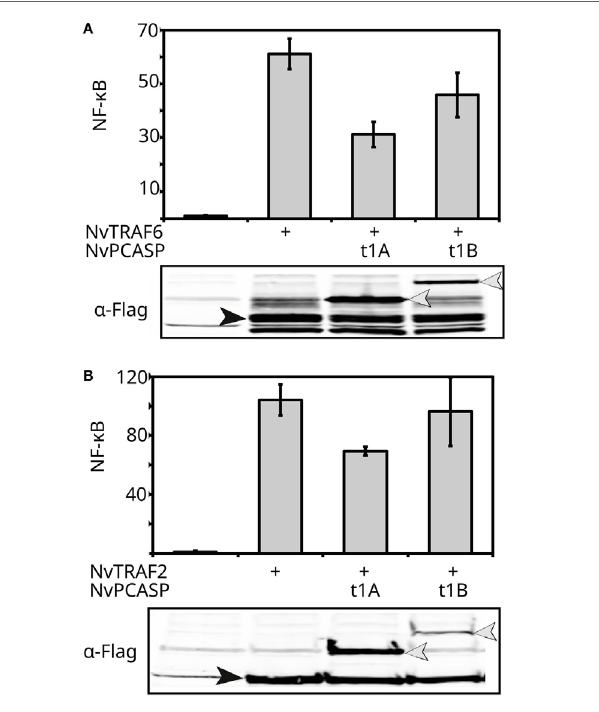
FigUre 4 | Functional conservation of cnidarian TRAF6 and TRAF2. (a,B) Nematostella vectensis (Nvn) TRAF6 (a) or TRAF2 (B) was expressed in human HEK293T cells together with an NF- κ B-dependent luciferase reporter gene and a constitutively expressed β -galactosidase reporter gene plasmids. The TRAF was transfected either alone or together with the indicated Nvn HLH-paracaspase fusion protein. Luciferase values were normalized against β -galactosidase and expressed as fold induction compared to samples not expressing the TRAF. Error bars represent 95% confidence intervals (Student’s t -distribution). The lower part of the panel shows the expression of the TRAF (closed arrow head) and each Flag-tagged HLH-fused type 1 paracaspase (open arrow heads) as revealed by Western blotting and development with anti-Flag antibodies. Experiments were repeated at least twice.